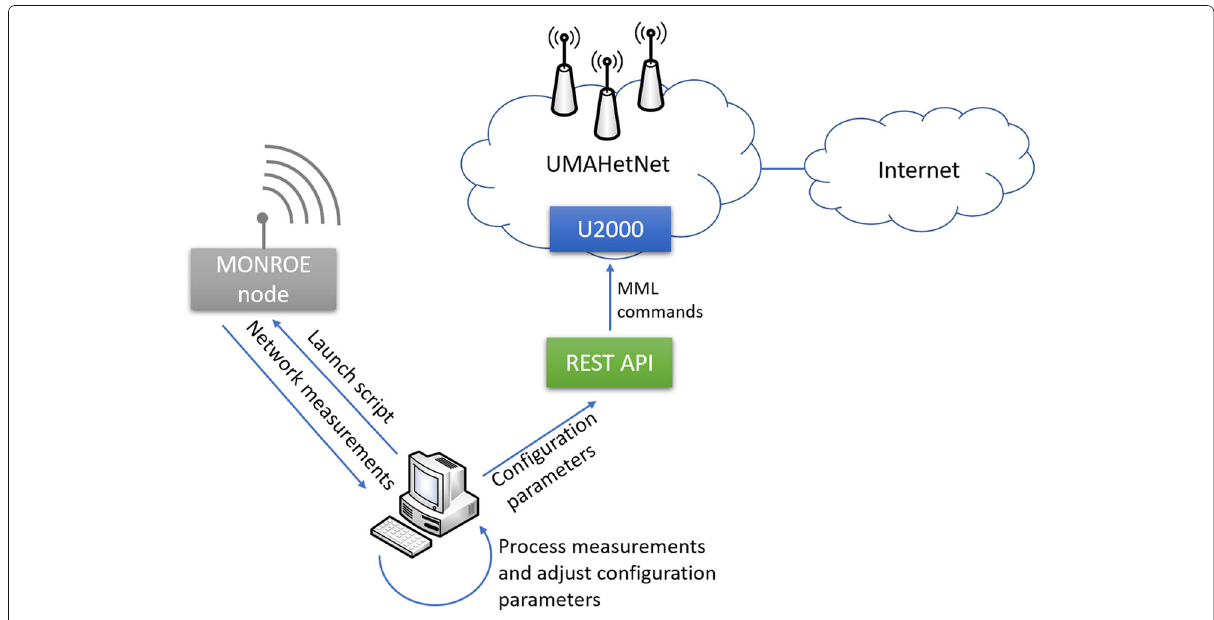
Fig. 6 Integration of hardware